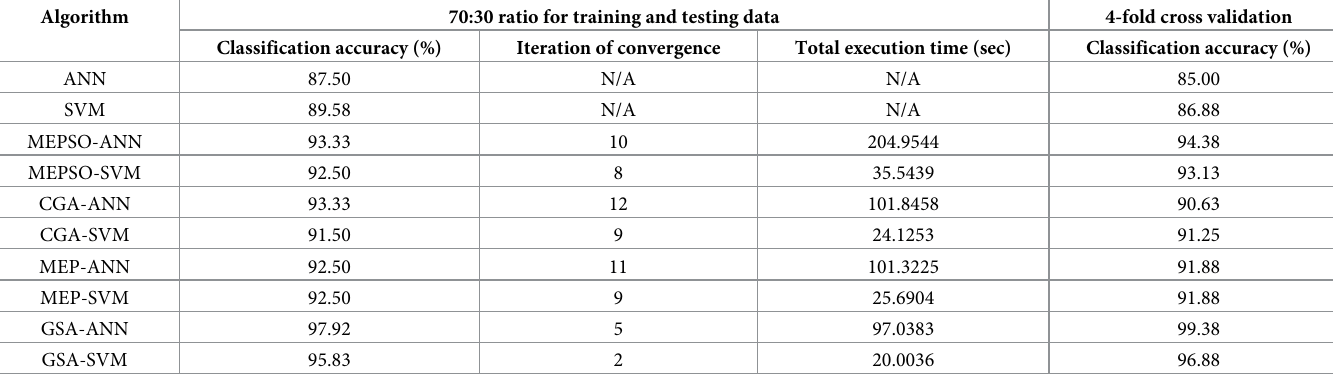
Table 10. Results comparison between different algorithms.